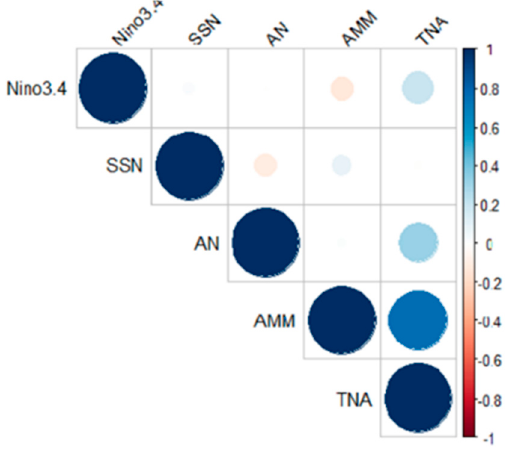
Figure 4. Positive correlations are displayed in blue and negative correlations in red. The intensity of the color and the size of the circles are proportional to the correlation coefficients. To the right of the correlogram, the color legend shows the correlation coefficients and the corresponding colours.